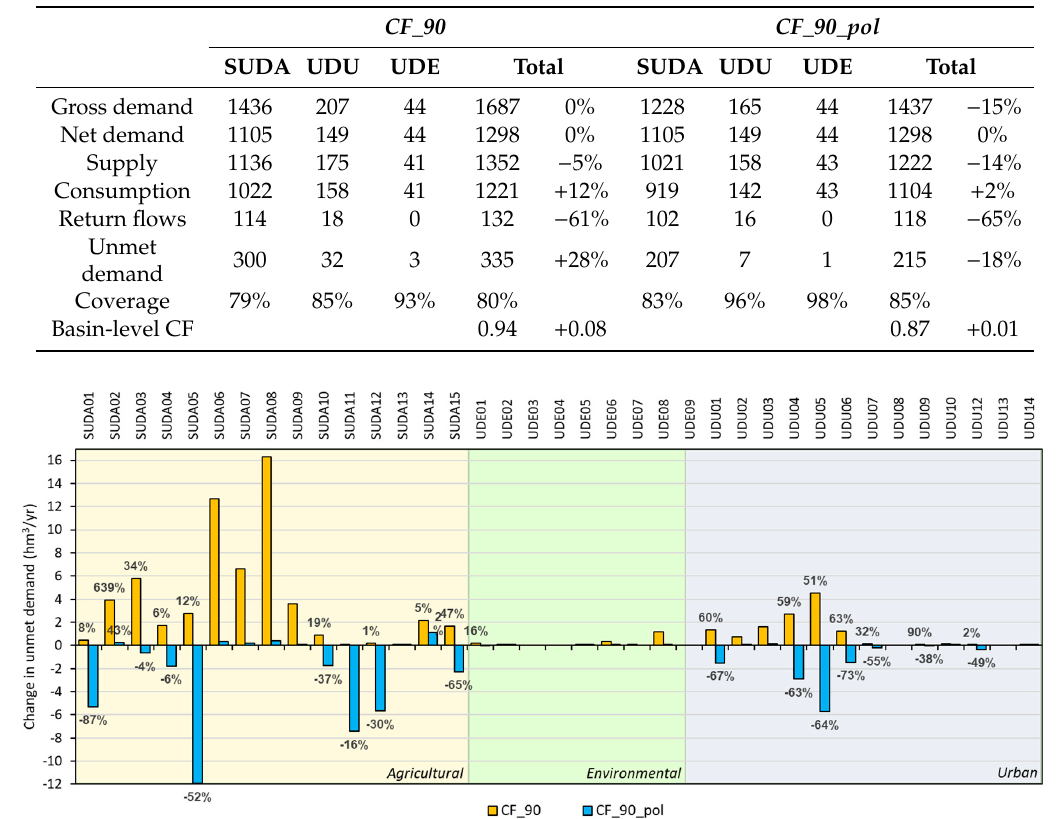
Figure 9. Changes in unmet demand in the two scenarios, with respect to baseline conditions. Percentages indicate the relative unmet demand change for all demand sites with non-zero unmet demand under reference conditions.